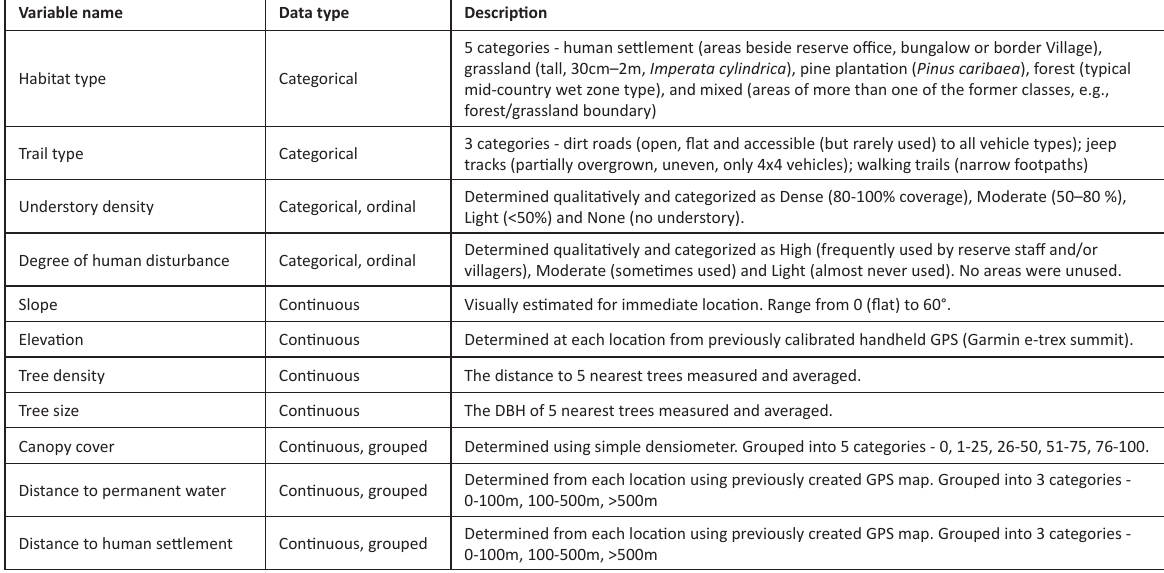
Table 2. Description of variables investigated for Leopard habitat selectivity analysis.